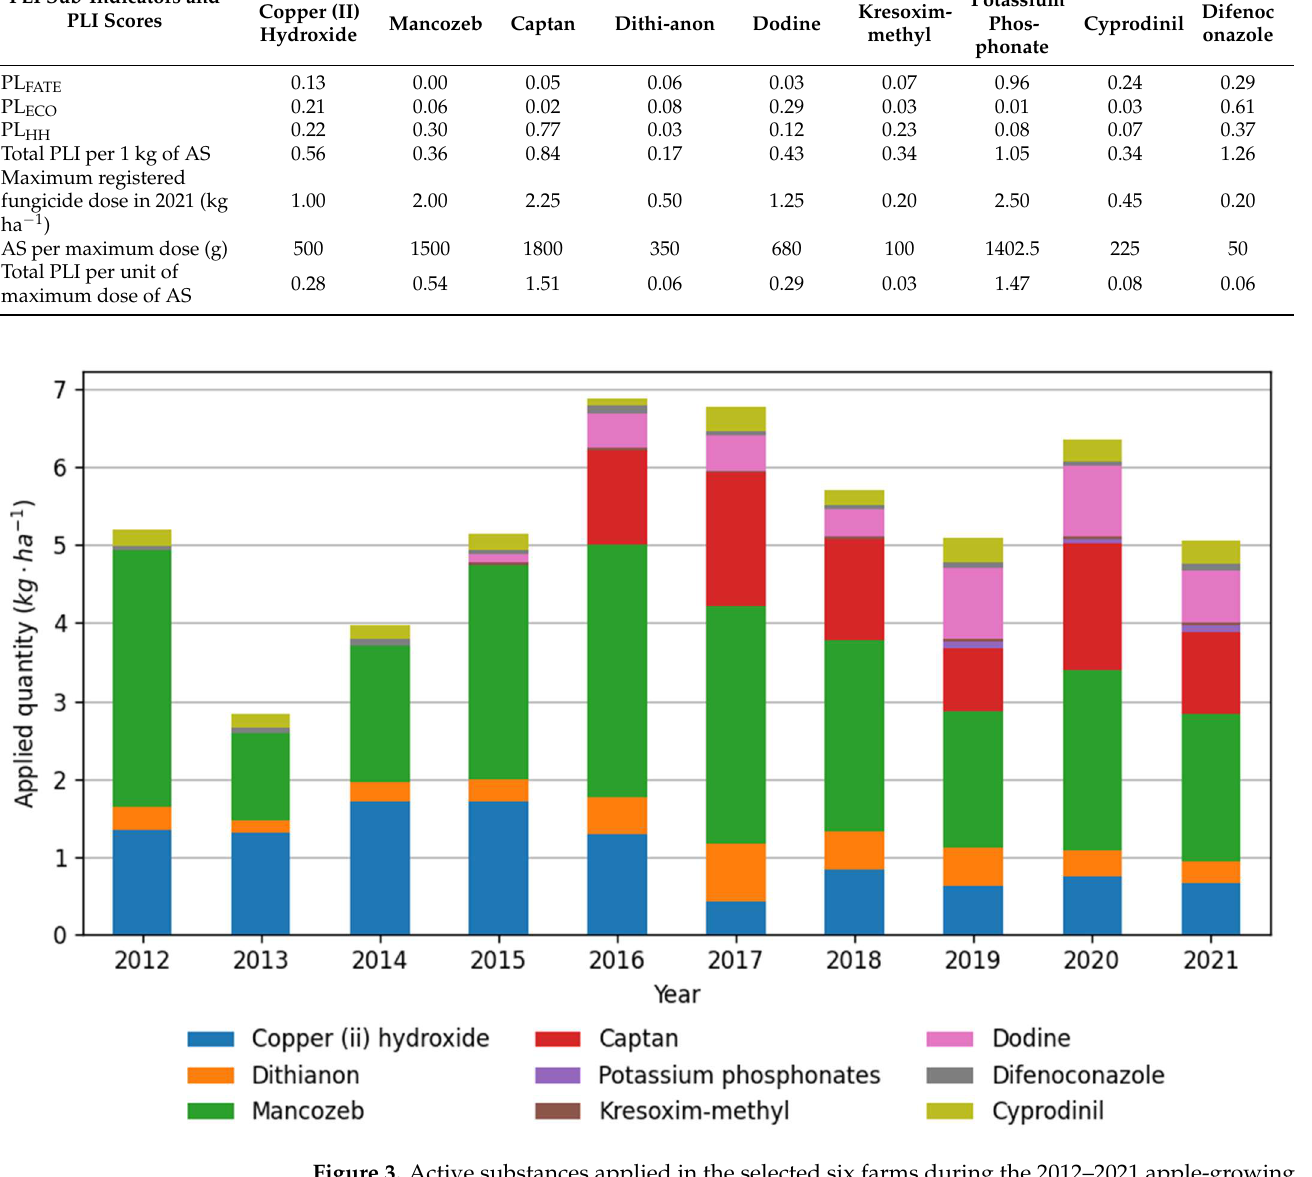
Figure 3. Active substances applied in the selected six farms during the 2012–2021 apple-growing seasons. Data are the means of the consumption of active substances in six farms.